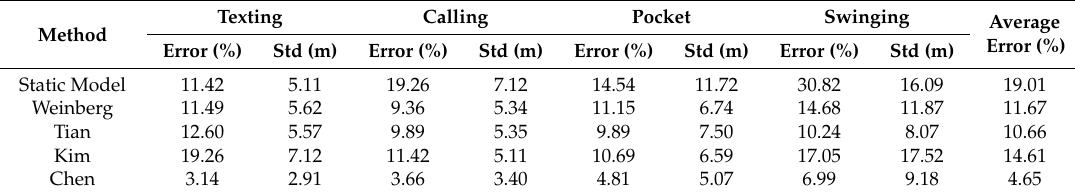
Table 7. Step length error